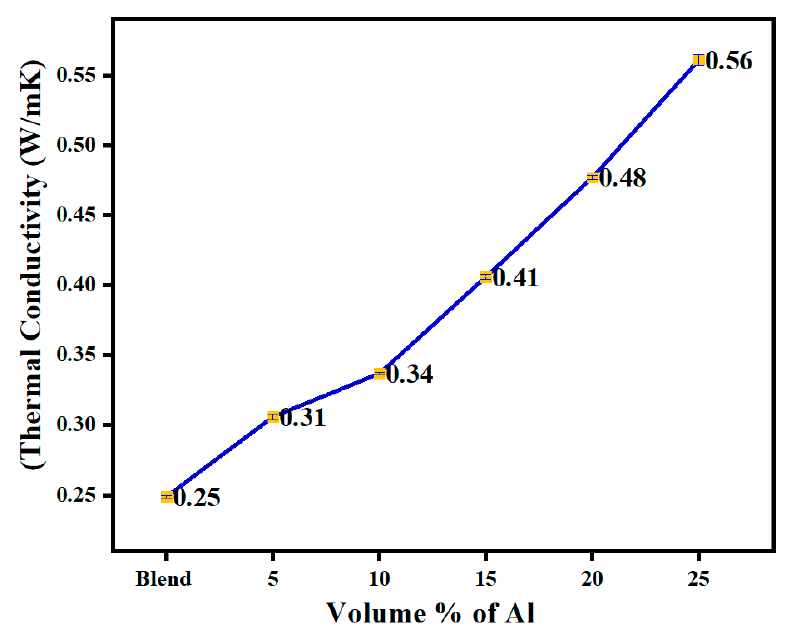
Figure 8 . The thermal conductivity of Al nano platelet composites, at room temperature . Figure 8. The thermal conductivity of Al nano platelet composites, at room temperature.